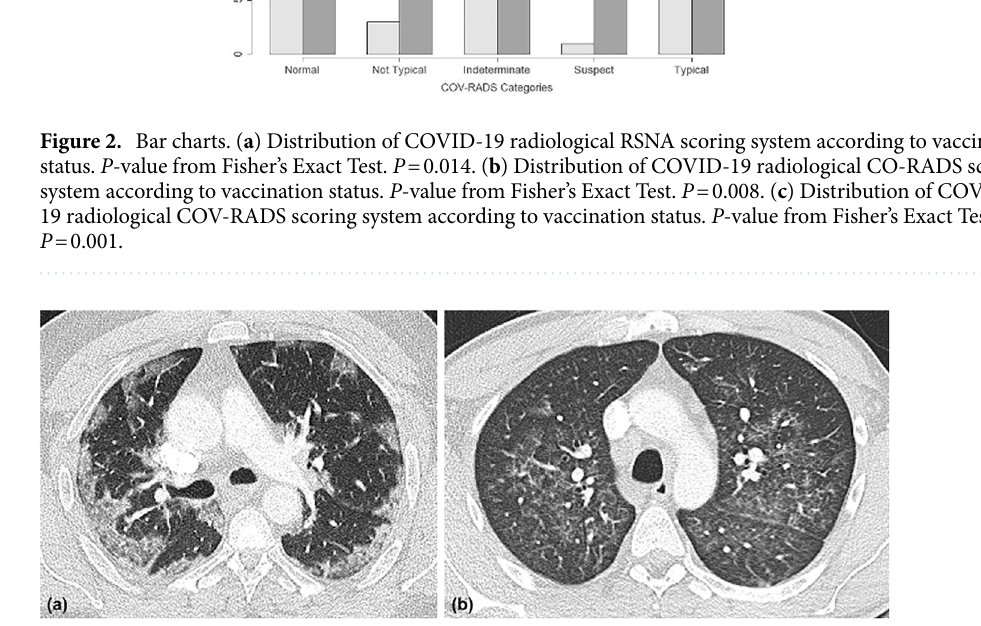
Figure 3. ( a ) 51-year-old non-vaccinated male patient with typical findings of COVID-19 pneumonia, delta- variant: subpleural ground glass opacities (GGO) in a bilateral distribution; ( b ) 37-year-old vaccinated male patient with atypical distribution of COVID-19 pneumonia: peribronchovascular nodular